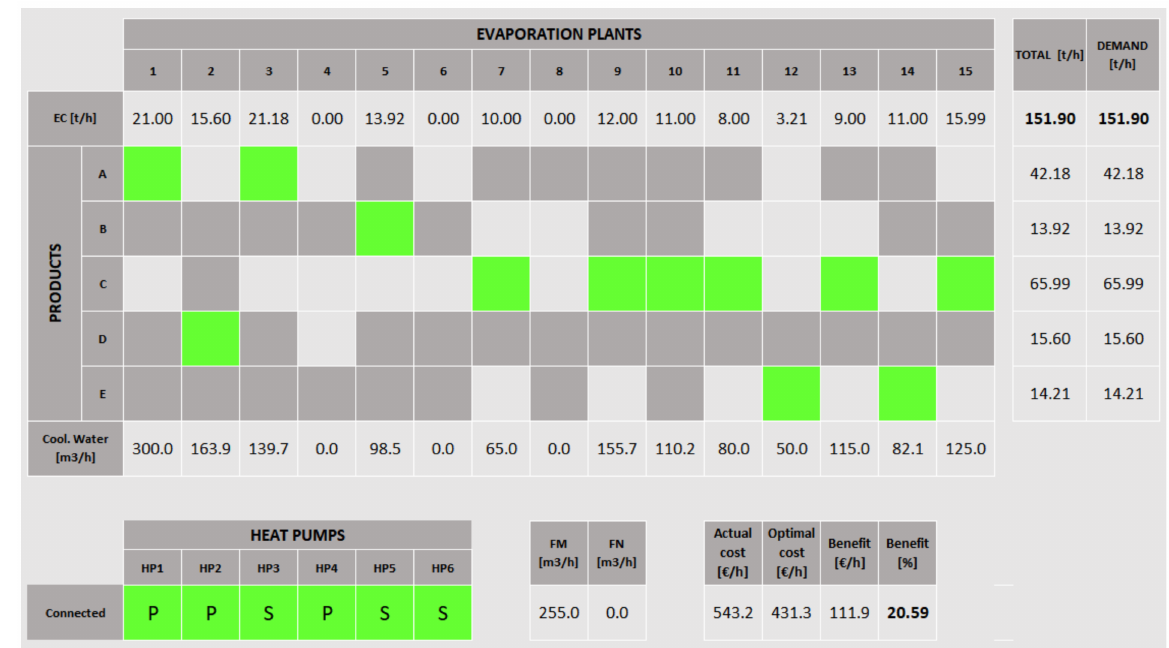
Figure 6. Designed HMI interface. Columns represent the evaporation plants. The first row indicates the evaporation load in t/h. The next five rows correspond to the products and the last one displays the cooling water to each SC. Current load assignation arises in the green boxes. Dark gray boxes indicate forbidden